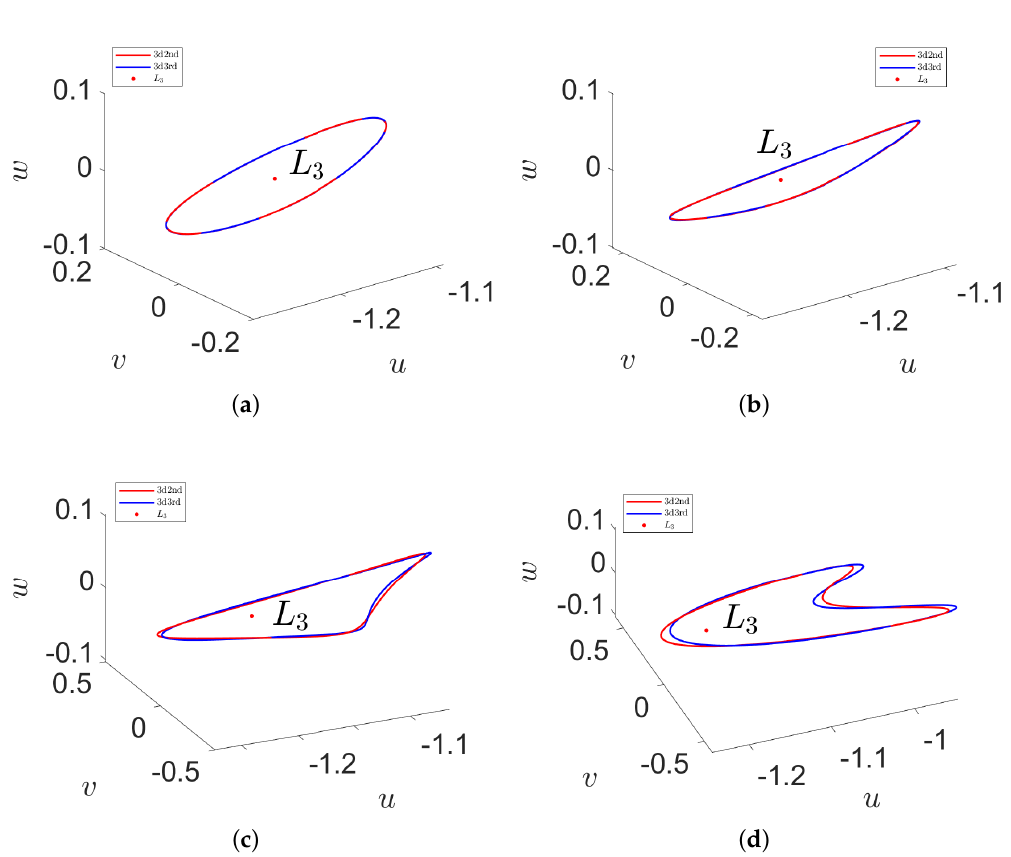
Figure 10. The approximate periodic solutions in three-dimensional space for ( a ) κ = 0.5, ( b ) κ = 1, ( c ) κ = 2, and ( d ) κ = 4,